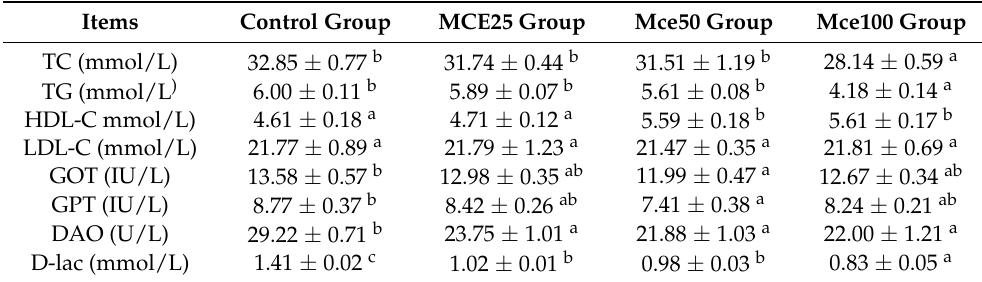
Table 2. Effects of dietary MCE supplementation on the serum biochemical parameters of the juvenile American eel.